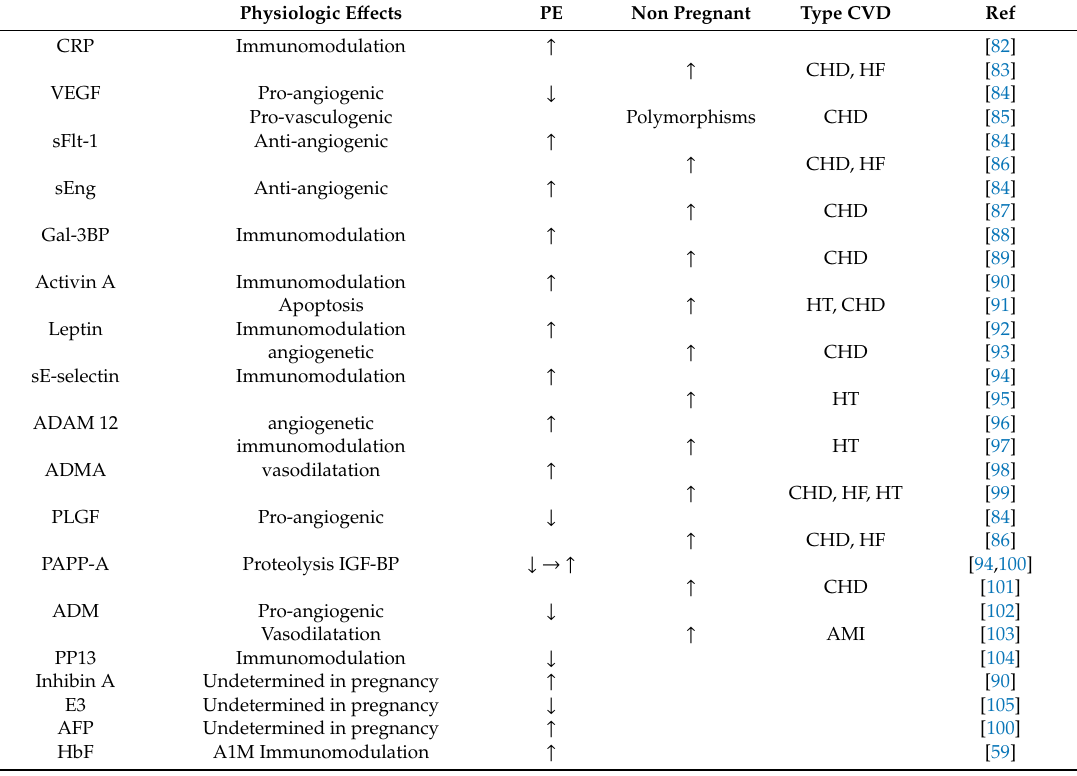
Legend to Table 3: PE: Preeclampsia; CVD: Cardiovascular disease; ↑ : High serum concentration; ↓ : Low serum concentration; ↓ → ↑ : Serum concentration changing from low to high; CHD: Coronary heart disease;